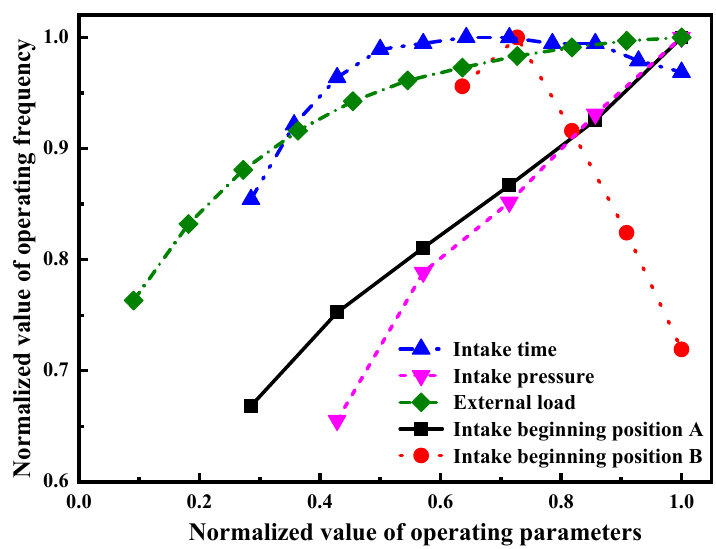
Figure 19. Influence of operating parameters on operating frequency.